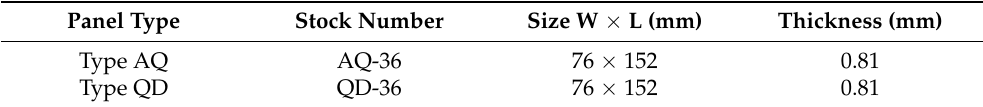
Table 6. Q-PANEL standard test substrate dimensions.